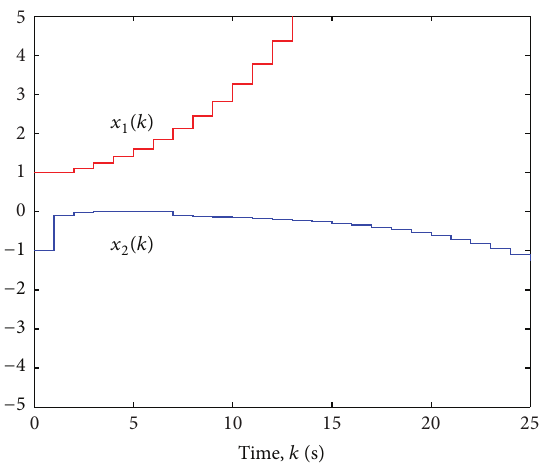
Figure 3: State responses of the subsystems 1. Figure 4: State responses of the subsystems 2.